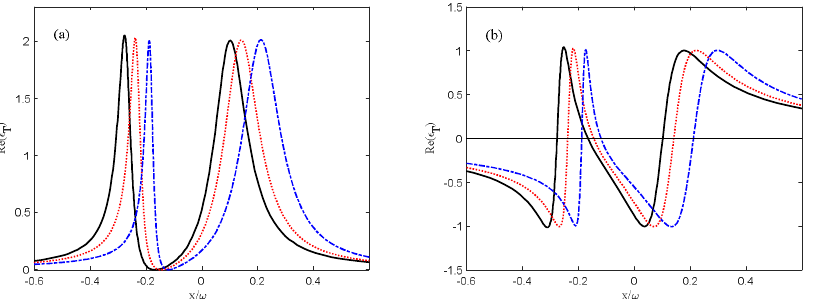
 as a function of normalized detuning T